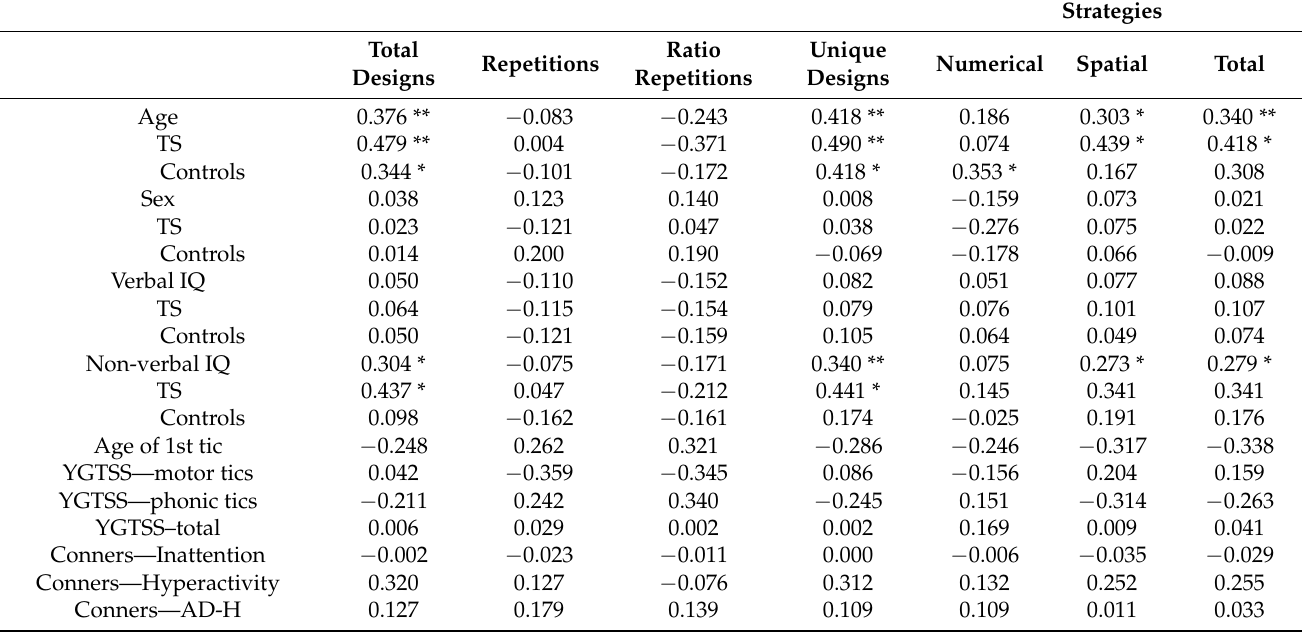
Table 2. Pearson Correlations between Demographics, including TS and ADHD symptoms, and FPT Global Measures.